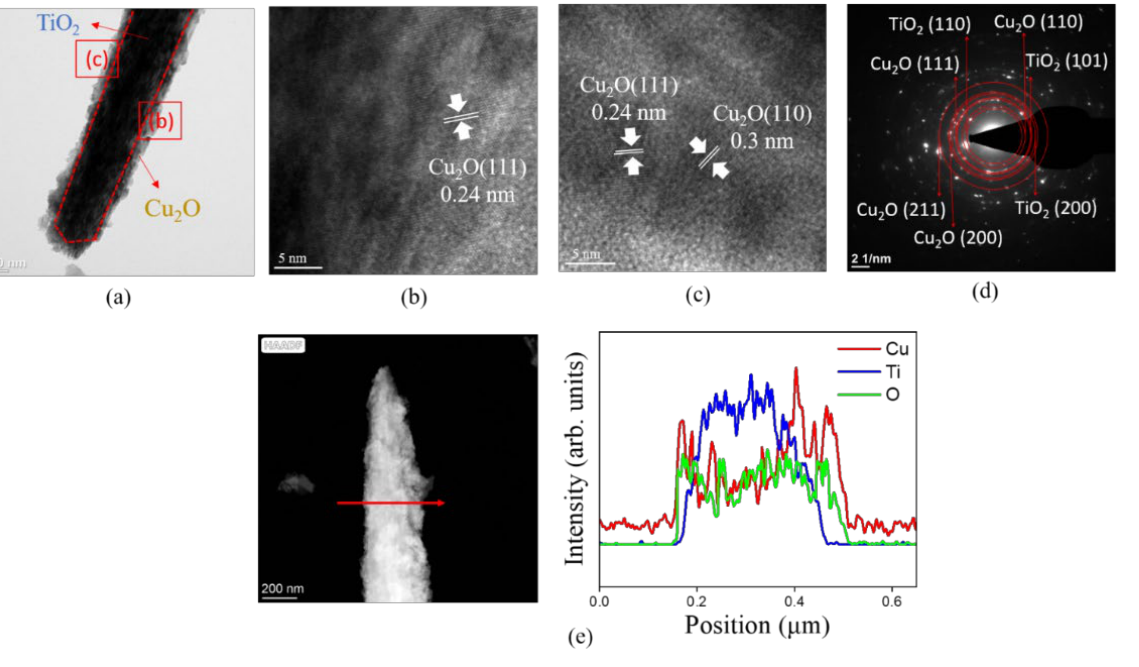
Figure 3. TEM analysis of TC200: ( a ) low-magnification TEM image; ( b , c ) HRTEM images of various regions of the composite rod as marked in ( a ); ( d ) SAED patterns of several TC200 nanorods; ( e ) EDS line scanning profiles across the composite rod.